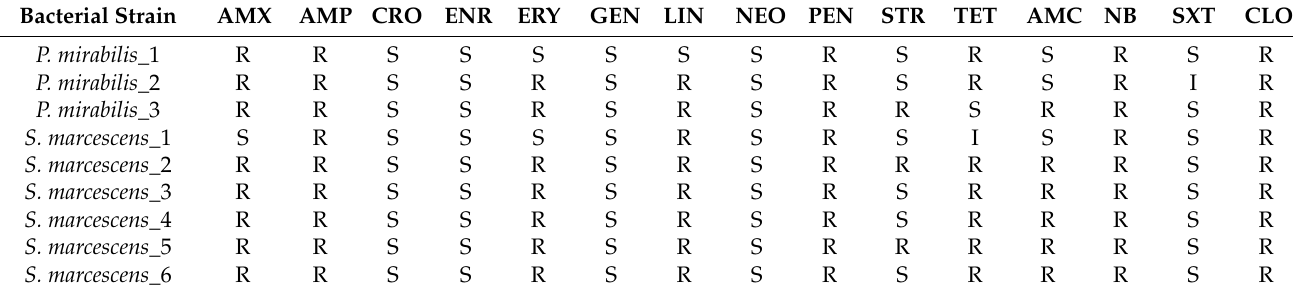
Table 2. Antimicrobial sensitivity pattern of S. marcescens and P. mirabilis strains isolated from cows with mastitis (S—sensitive, I—intermediate, R—resistant). AMX, amoxycillin; AMP, ampicillin; CRO, ceftriaxone; ENR, enrofloxacin; ERY, erythromycin; GEN, gentamicin; LIN, lincomycin; NEO, neomycin; PEN, penicillin; STR, streptomycin; TET, tetracycline; AMC, amoxicillin/clavulanic acid; NB, novobiocin; SXT, trimethoprim/sulfamethoxazole; CLO, cloxacillin. Bacterial Strain AMX AMP CRO ENR ERY GEN LIN NEO PEN STR TET AMC NB SXT CLO